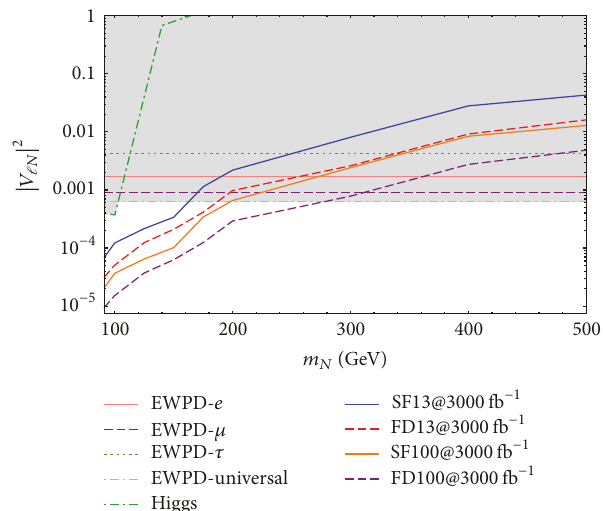
Figure 26: Bounds on the square of the mixing angle from the trilepton plus MET final state as a function of the heavy neutrino mass (𝑚 𝑁 ) . The shaded region is ruled out by the EWPD and Higgs data. Prospective bounds from the Higgs data had been calculated in [45] for the LHC at the high luminosity (3000 fb −1 ) and future 100 TeV pp